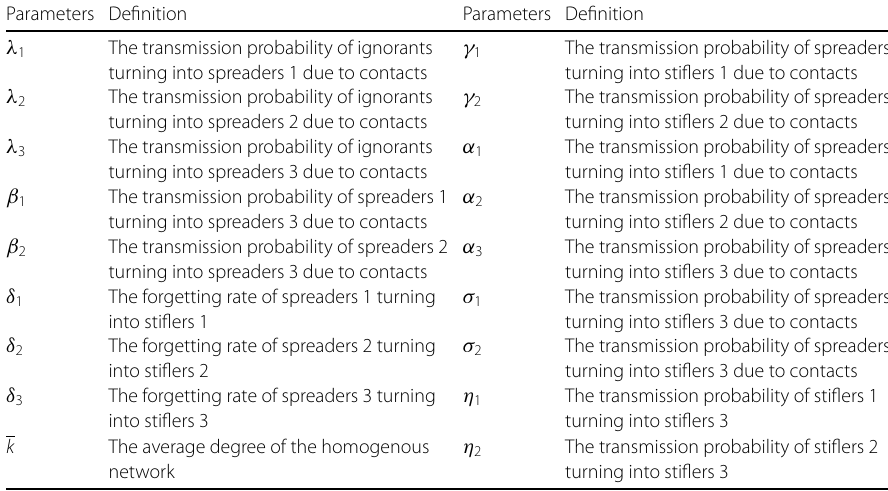
Table 1 The involved parameters and their definition in the 3SI3R model Parameters